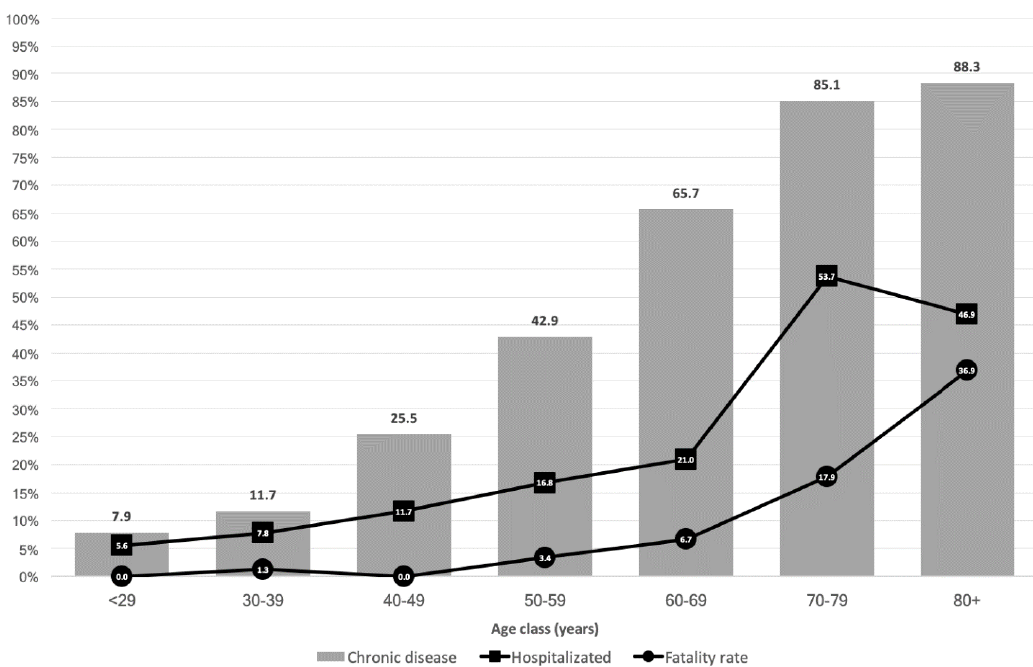
Figure 2. Proportion of patients per age class with at least one chronic disease, hospitalization rate for COVID-19, and fatality rate. Table 1. The determinants of hospitalization according to multivariate logistic regression models for the total population and for patients 65+ years of